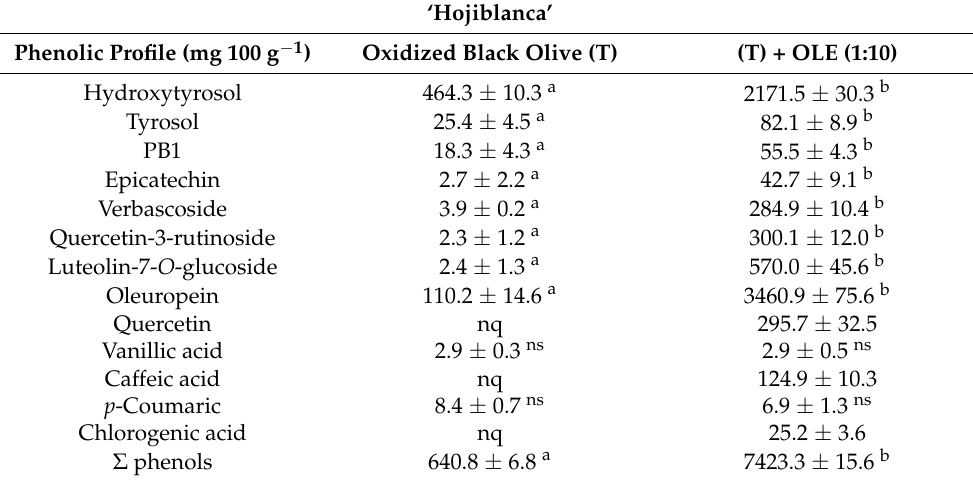
Results are expressed as mean ± SD of the three sample replicates. Different small letters in the same row indicate significant statistical differences (Tukey ´ s HSD test, p < 0.05) among treatments. PB1: Procianidine B1; ns: not significant; nq: not